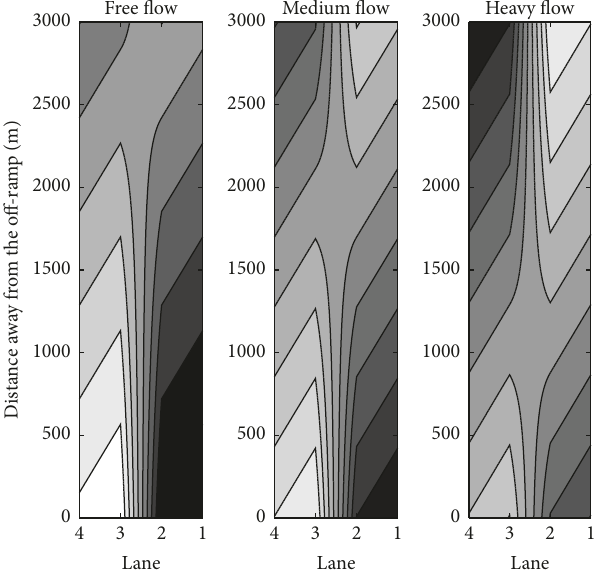
Figure 8: Lane-changing prob. sketch diagram in freeway off-ramp areas.